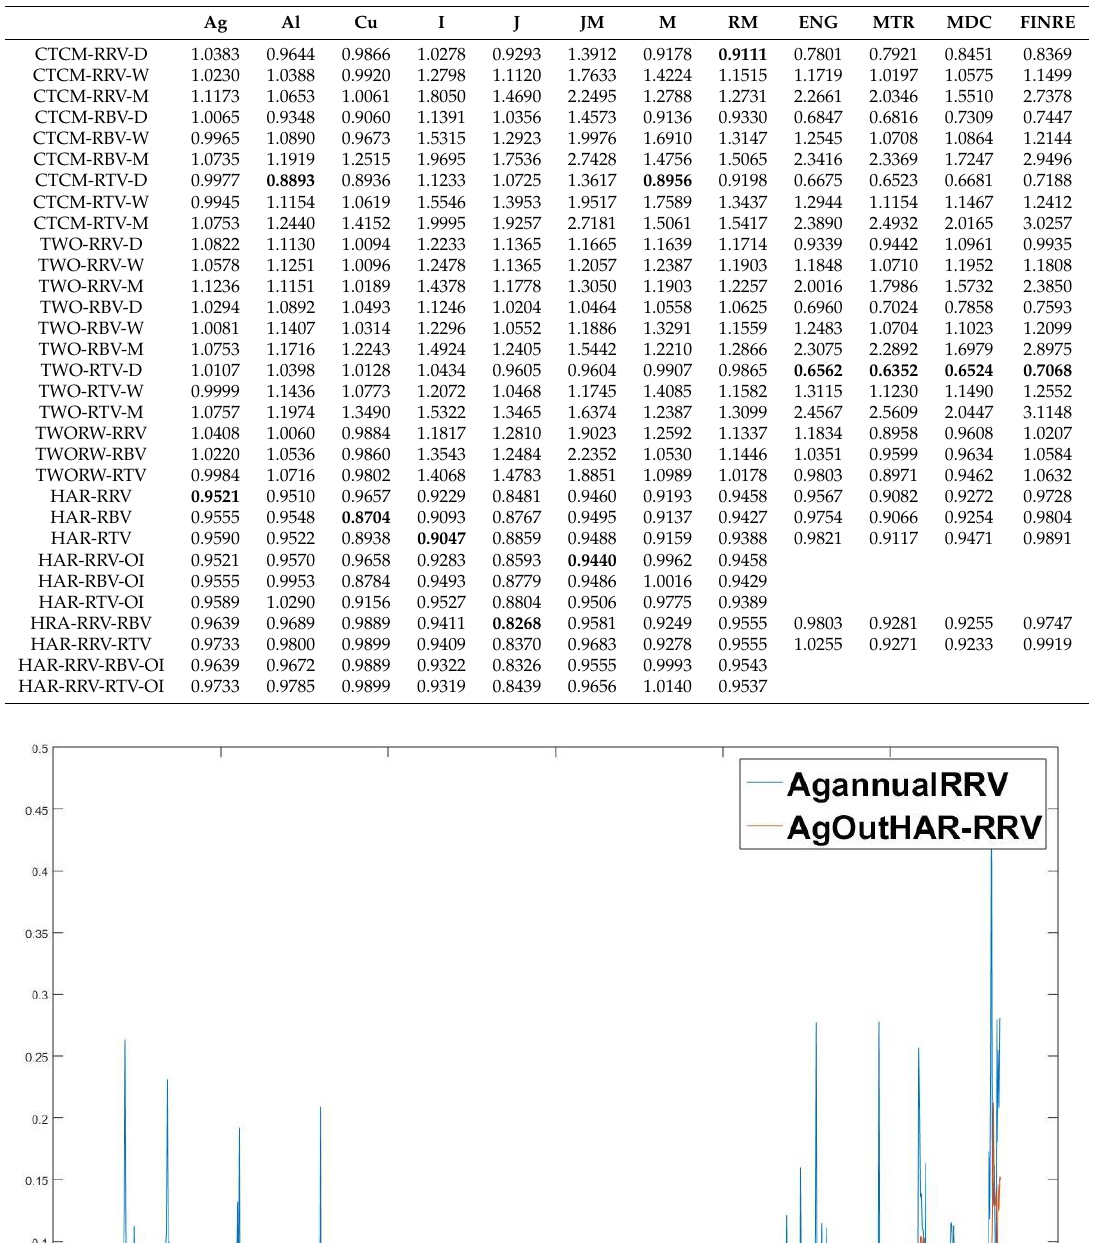
Table 7. The results of out of sample forecast Theil’s U.